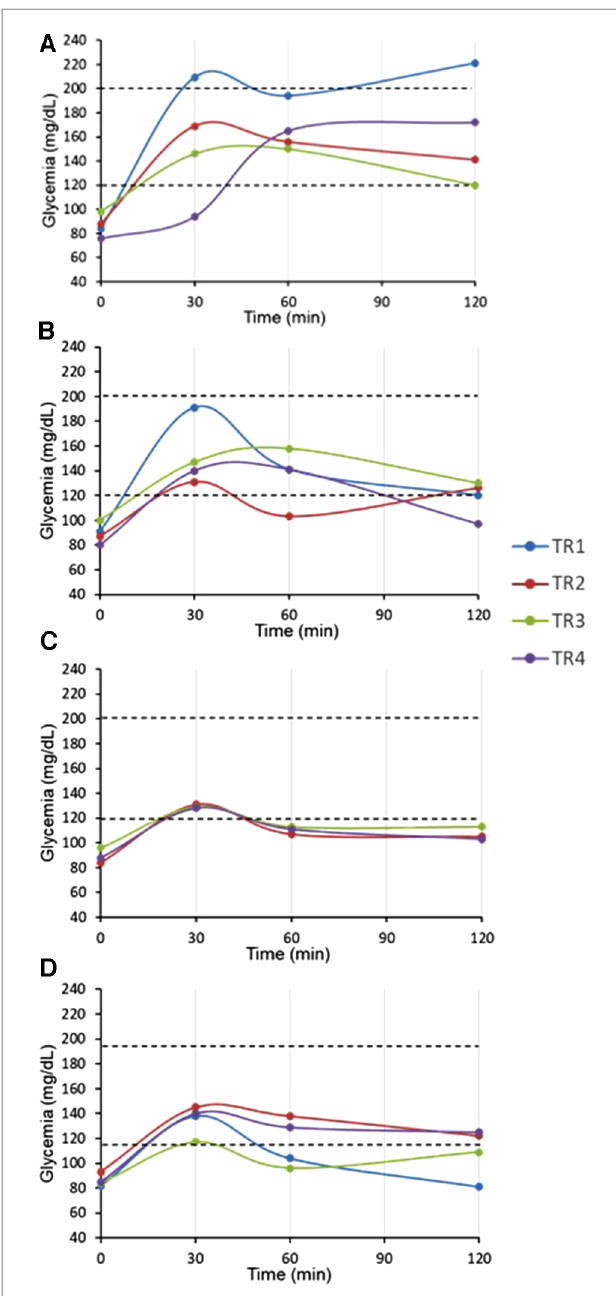
FIGURE 8 OGTT at one, three, six and nine-month post-renal transplant children (pDIABGRAFT). The oral glucose tolerance test (OGTT) performed at ( A ) one-month post RT showed that fasting glucose were in the normal range whereas two patients (TR2, TR4) presented impaired glucose tolerance (>140 mg/dl) at the end of the test, suggesting prediabetes and one presented glycemia above 200 mg/dl (TR1) at 120 ′ , corresponding to overt diabetes. At ( B ) three-, ( C ) six- and ( D ) nine- months post-RT, all patients had normalized their glycemia at the end of the